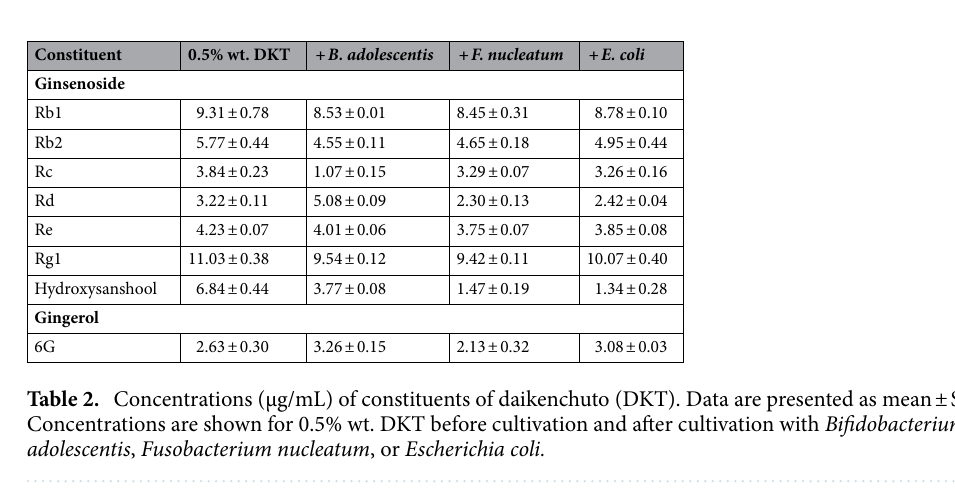
Figure 3. Growth of each studied bacterial species in the presence ( +) and absence (−) of daikenchuto (DKT). (A) Bifidobacterium adolescentis , (B) Fusobacterium nucleatum , and (C) Escherichia coli .